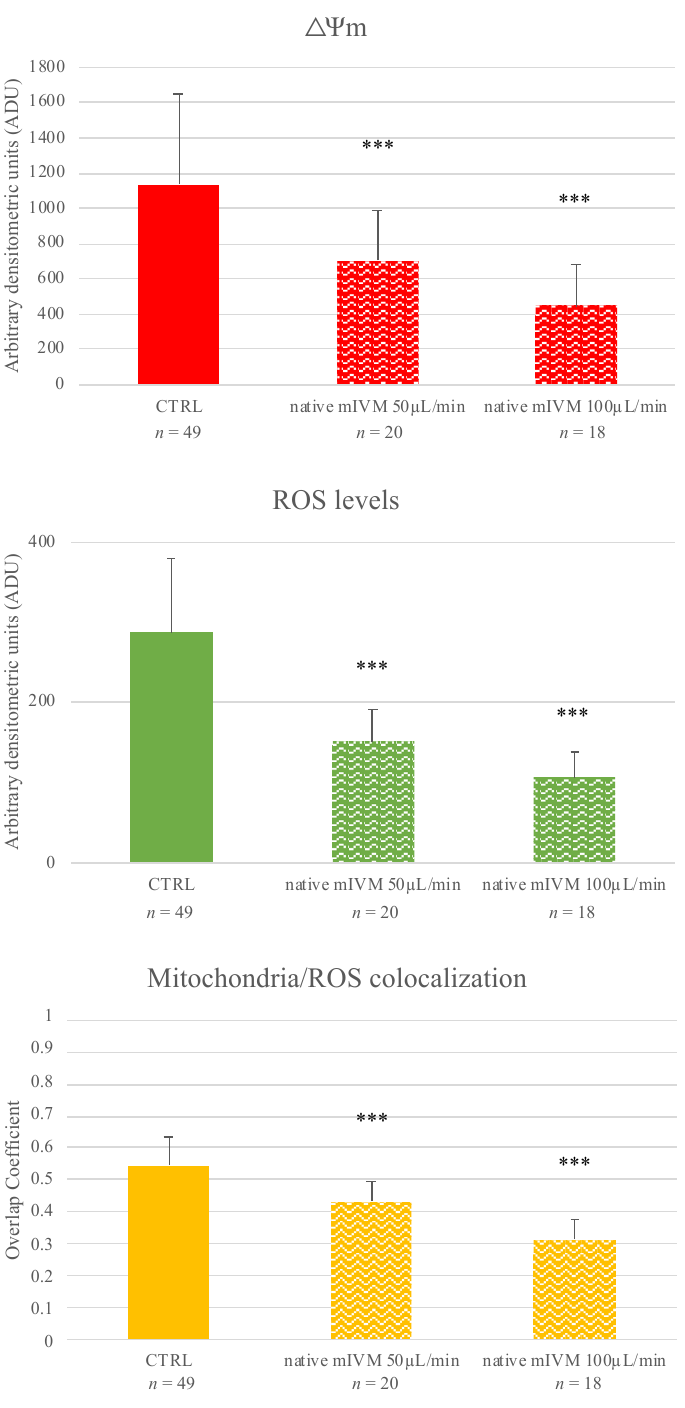
Figure 2. Effects of native mIVM performed at 50 or 100 µ L/min on mitochondria activity, intracellular ROS levels, and mitochondria/ROS colocalization of sheep MII oocytes . Numbers of analyzed matured oocytes are indicated at the bottom of each graph bar. One-way ANOVA, Dunnett’s Multiple Comparison Test: comparisons mIVM versus control *** p < 0.001 .